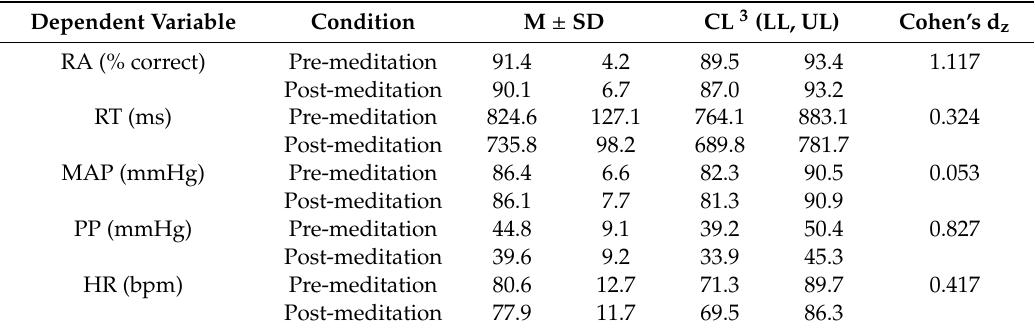
Table 1. Descriptive statistics for the behavioral 1 (response accuracy (RA), response time (RT)), and physiological 2 (mean arterial pressure (MAP), pulse pressure (PP), and heart rate (HR)) measures for the pre-meditation and post-meditation